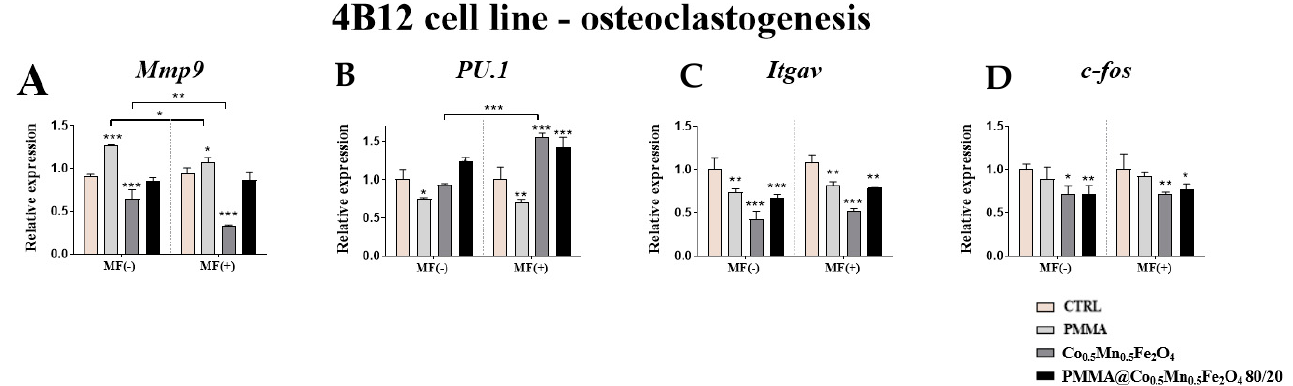
Figure 8. The impact of PMMA and its modification on the expression of genes related to osteoclastogenesis; Mmp9 ( A ), PU.1 ( B ), Itgav ( C ), c-fos ( D ) in the magnetic field condition towards mouse pre-osteoclasts (4B12 cell line). Statistical differences are indicates by * p < 0.005; ** p < 0.001 and *** p < 0.0001.